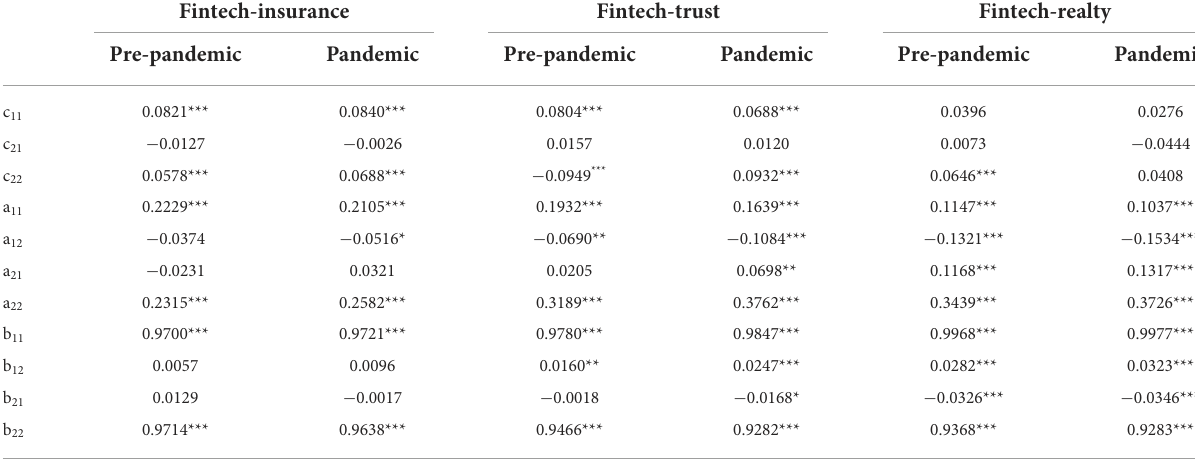
TABLE 4 Conditional variance estimation between fintech and other traditional financial